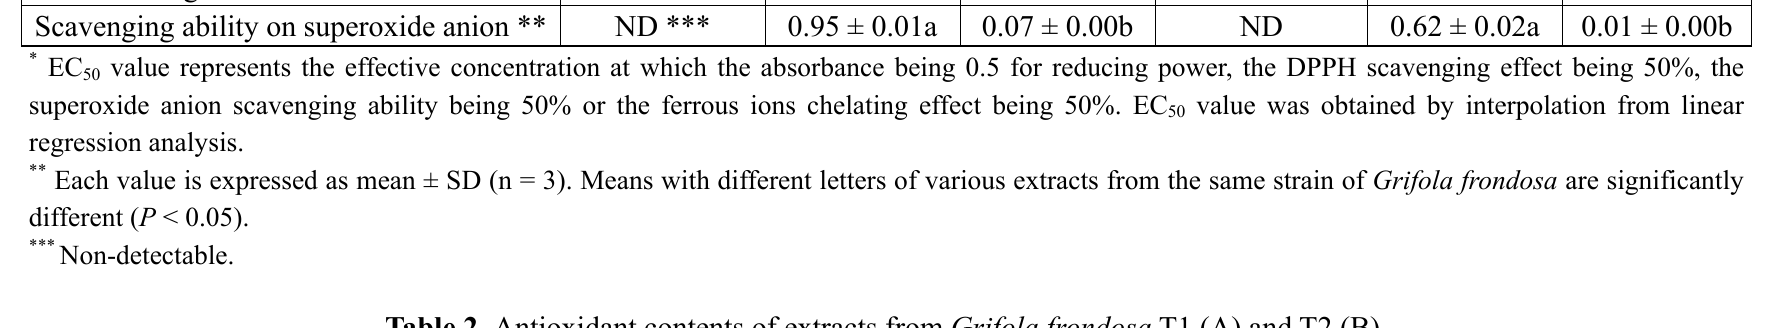
Table 2. Antioxidant contents of extracts from Grifola frondosa T1 (A) and T2